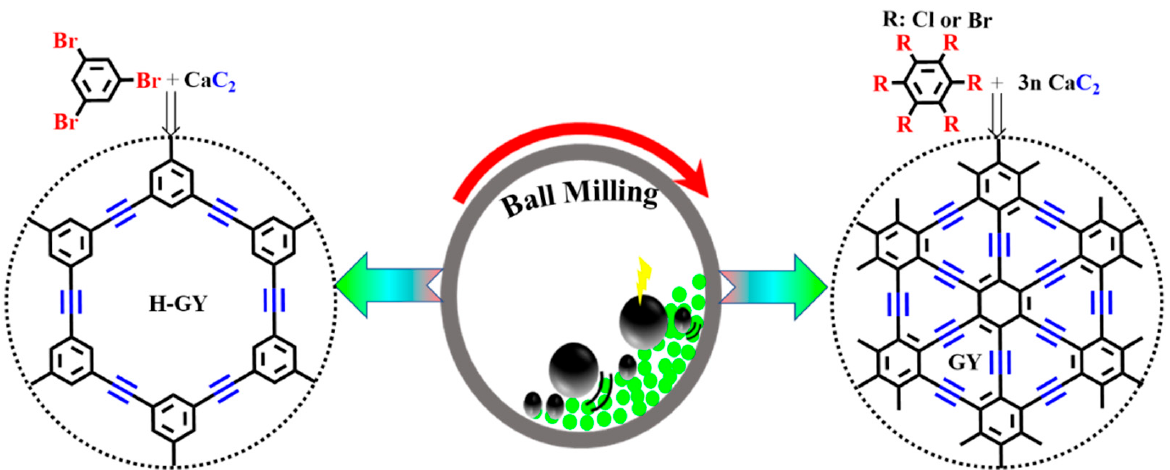
Figure 3. Schematic representation of mechanochemical synthesis for preparation of GY and its derivatives. Redrawn [60,61].